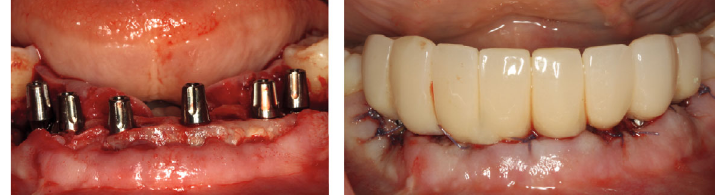
Figure 8: Installation of the de fi nitive prosthetic abutments and delivery of the temporary cemented restoration with immediate